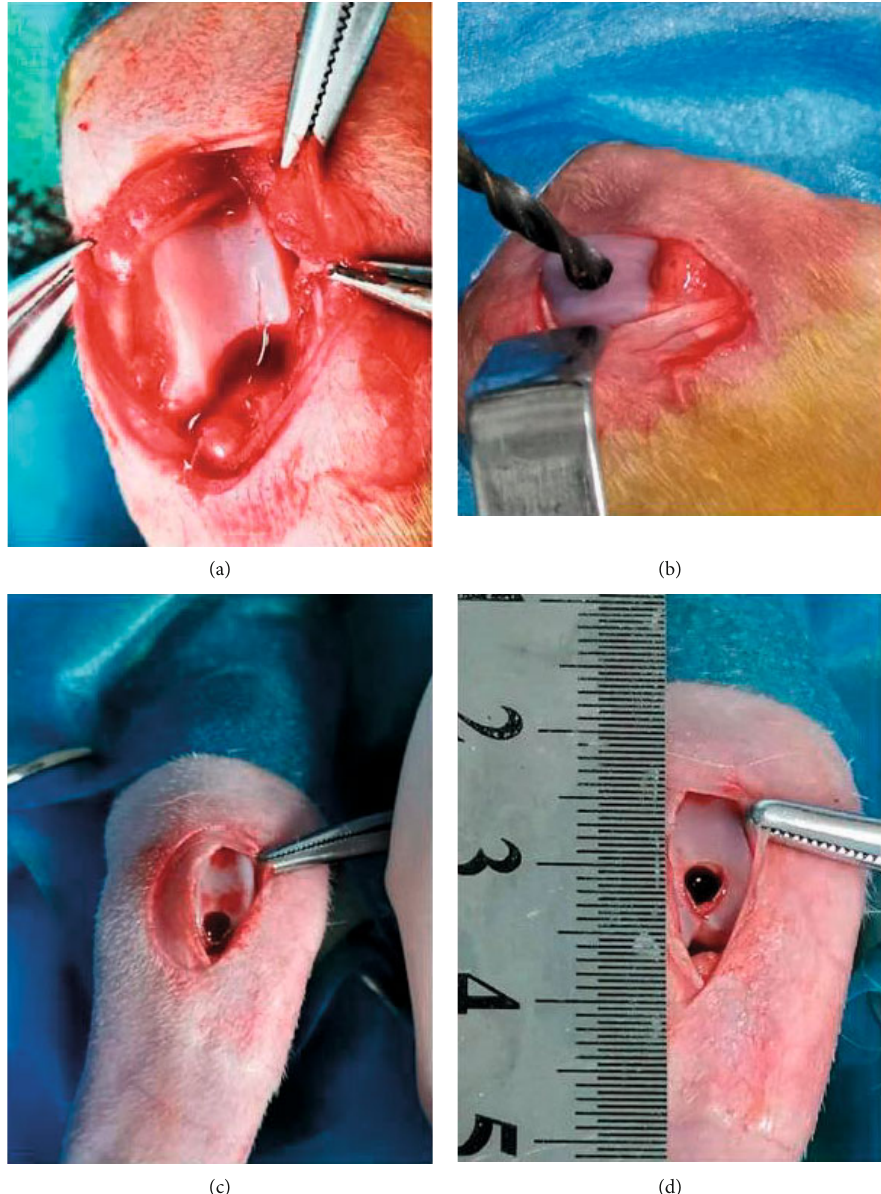
Figure 2: The operative process of creation osteochondral defects. (a) Exposing the articular surfaces of the trochlear grooves. (b) – (d) Creating osteochondral defects at the right knee joints (diameter: 3.5mm; depth: